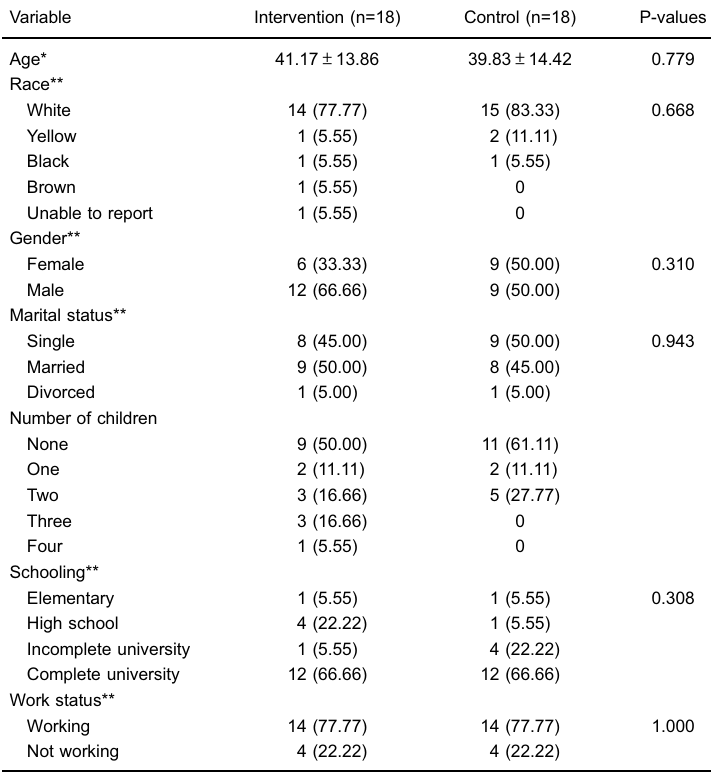
Table 1. Baseline characteristics of the control and intervention groups.